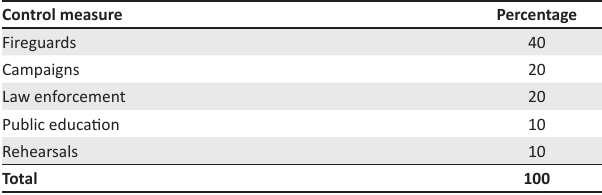
TABLE 2: Commonly practised veld-fire control measures. Control measure Percentage Fireguards Campaigns Law